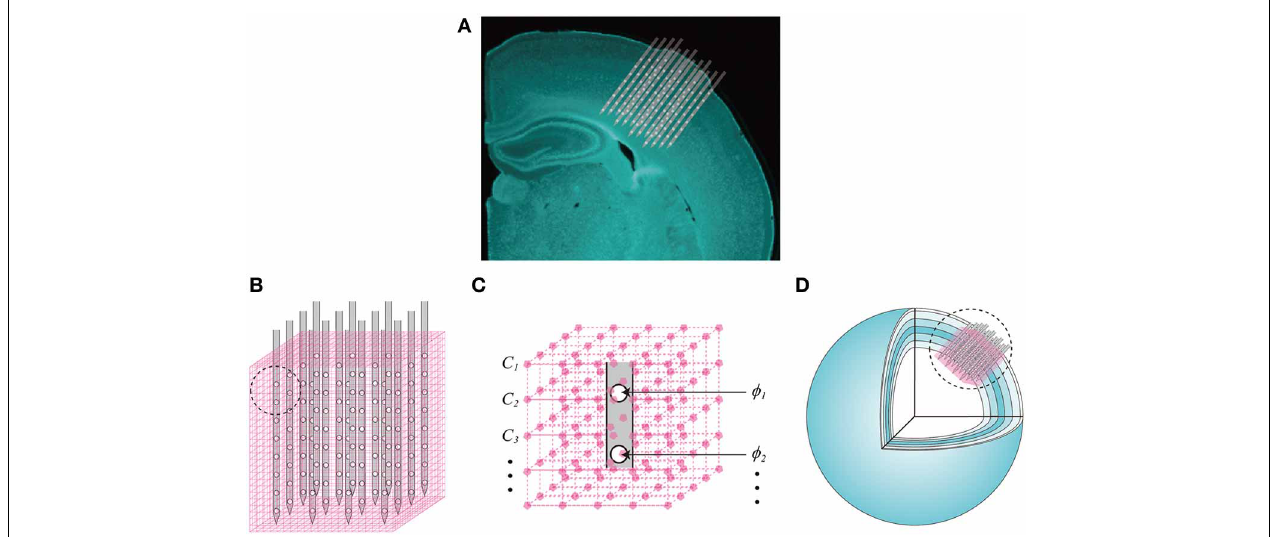
FIGURE 3 | Definition of the current source grid and the volume conductor model. (A) A composed fluorescent image of a Nissl stained coronal section of the rat brain and the illustration of the 3D array inserted into the somatosensory barrel cortex. (B) The current source grid (magenta) is defined for a ROI covered by the inserted 3D array. A magnified picture of the current source grid corresponding to the black-dashed-circle is also